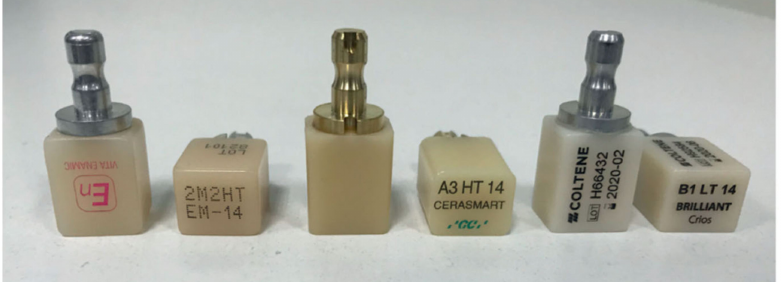
Figure 1. Examples of commercial CAD/CAM blocks. From the left: resin matrix composite Vita Enamic, resin matrix composite CERASMART and composite Brilliant Crios, reprinted with permission from ref. [44] (Copyright 2020 In˙zynier i Fizyk